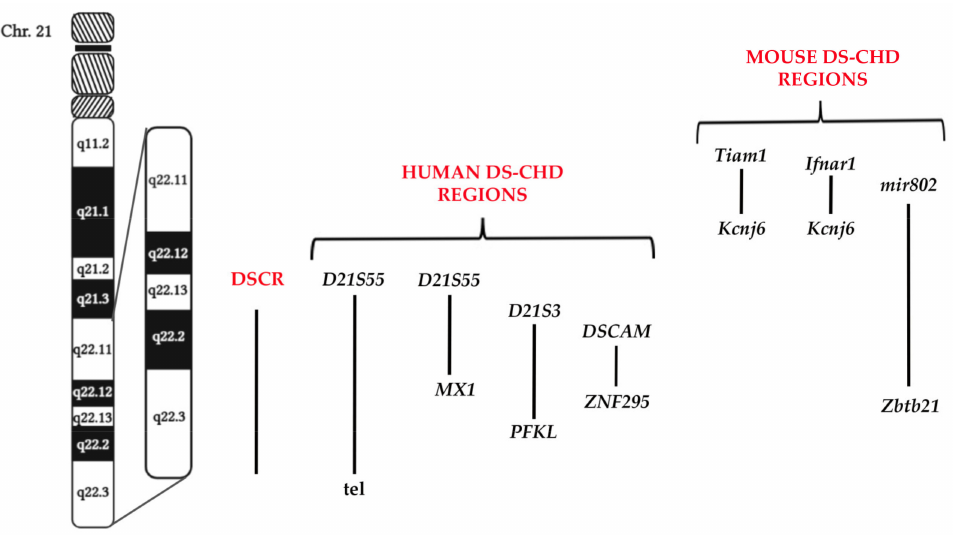
Figure 1. Schematic representation of DS phenotype critical regions. The ‘Down Syndrome Critical Region’ (DSCR) [8–10] and human [11–15] and mouse [19–21] DS–CHD regions with corresponding boundaries have been defined using the GRCh38/hg38 UCSC